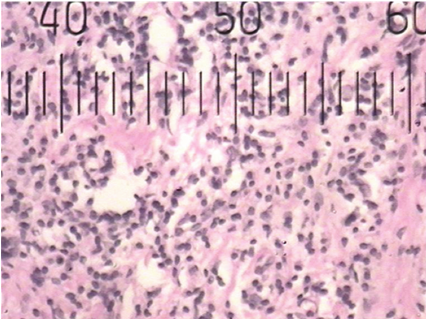
Figure 4: Histopathological photograph of gingival tissue in nonsmoker showing larger blood vessels.